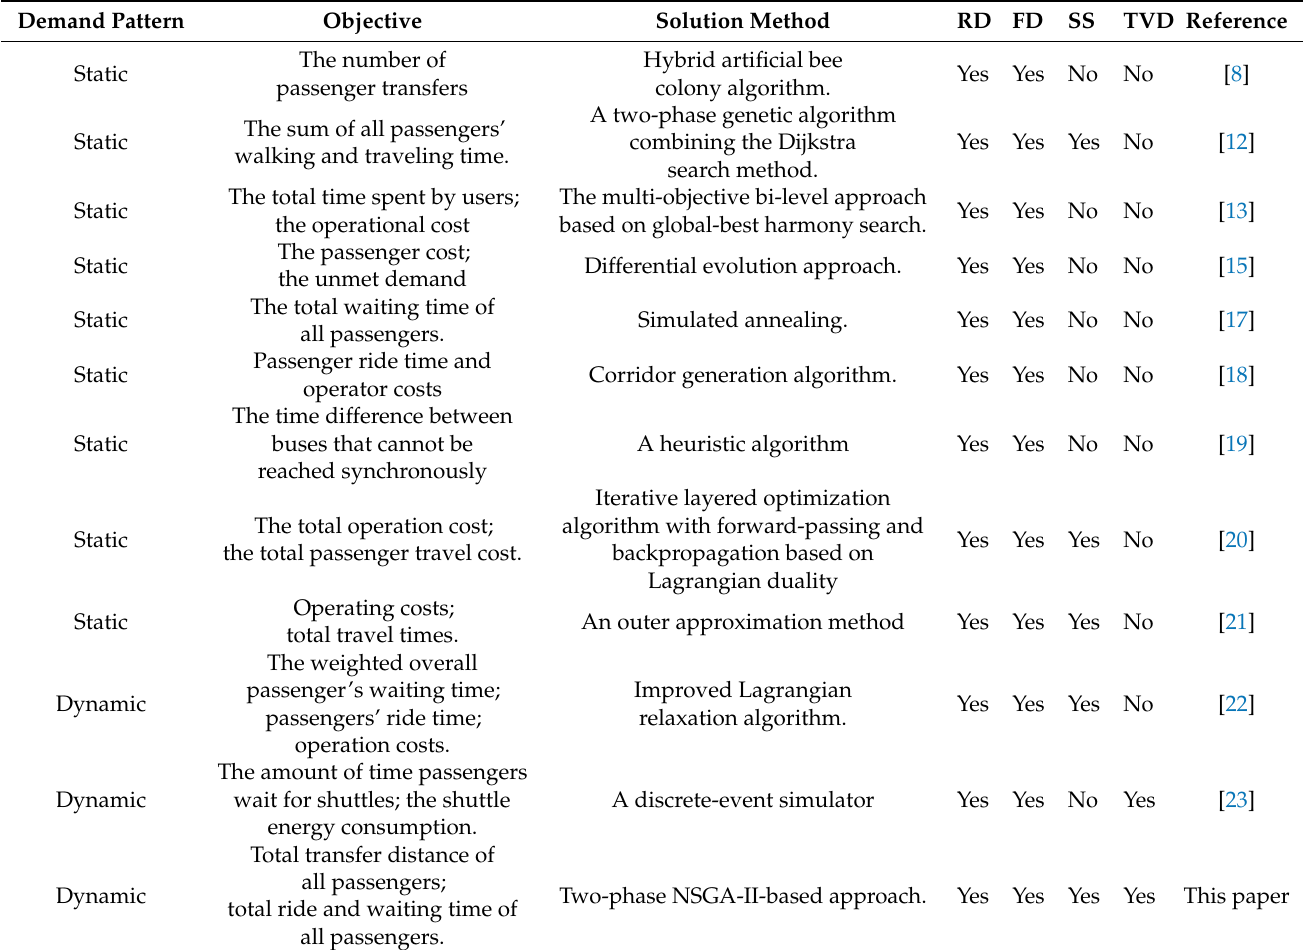
Table 1. State-of-the-art ASBN/CBN integrated optimization